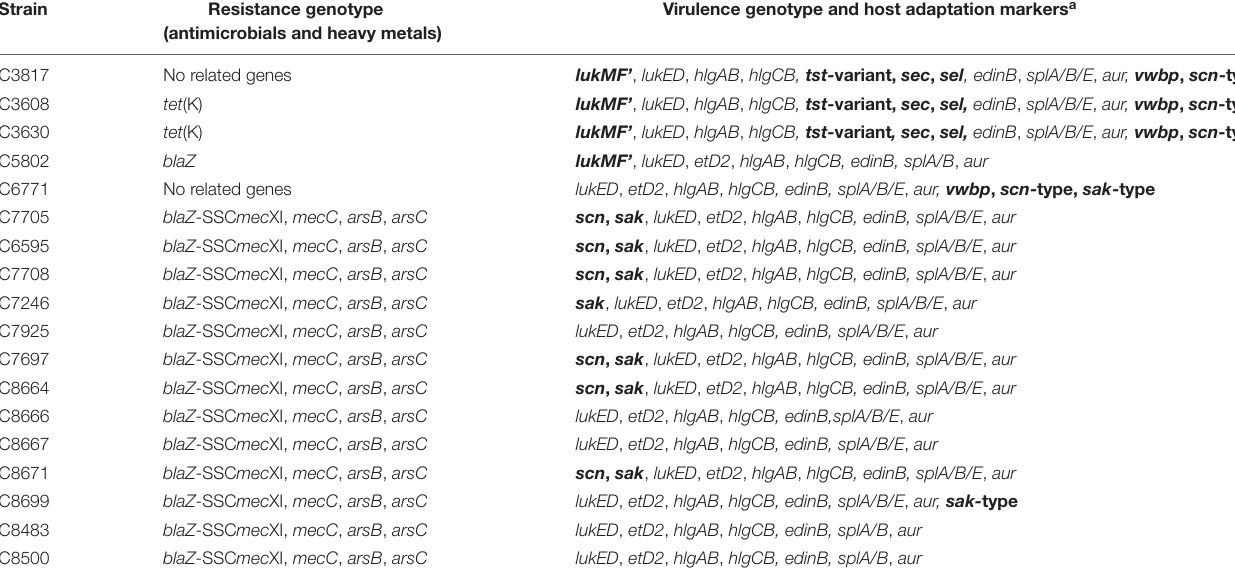
Virulence genotype and host adaptation markers